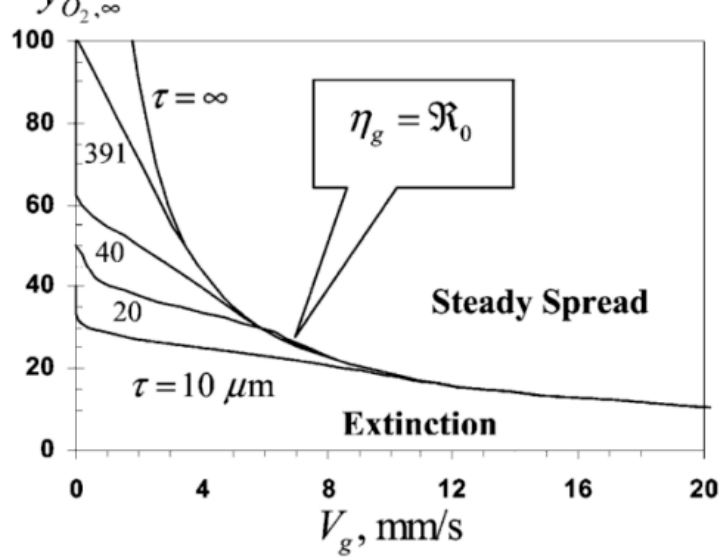
Figure 18. Relationship between y Figure 22. Relationship between y